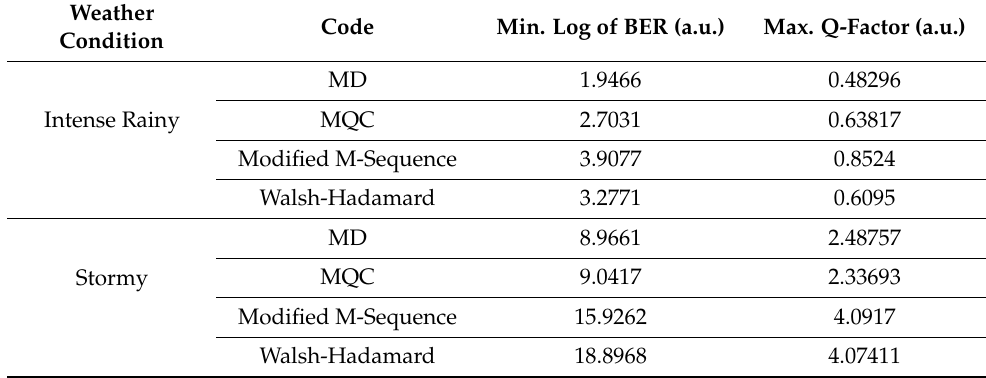
Table 5. Performance degradation with the increasing of FSO range in the AWGN channel.